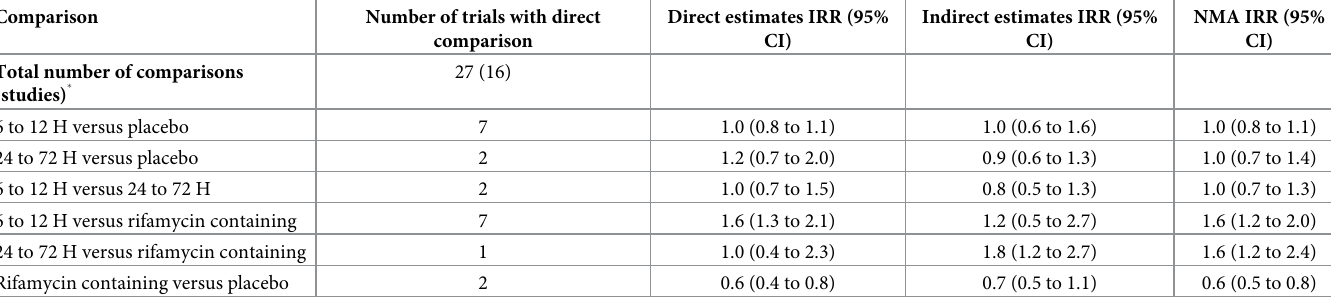
Table 4. NMA of incidence of all-cause mortality throughout study duration by aggregated TPT regimens. Comparison